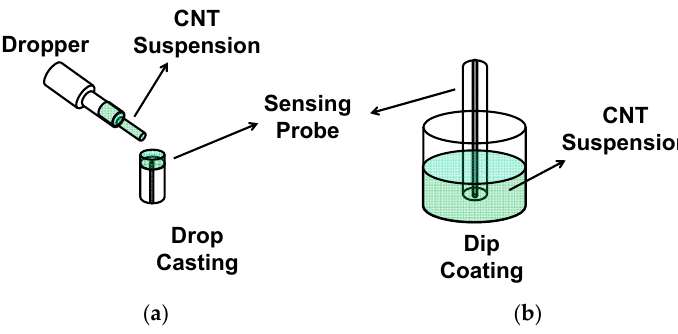
Figure 2. Illustration of the drop casting ( a ) and dip coating process ( b ) for the deposition of CNTs onto an optical fibre sensing probe.